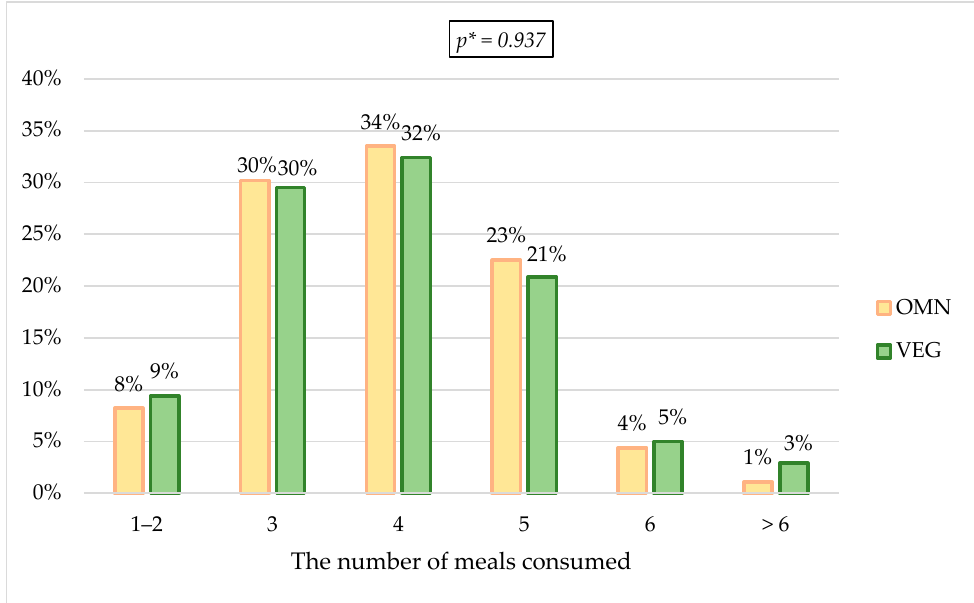
Figure 3. Changes in the number of meals before the pandemic. * p —calculated between the studied groups using Mann-Whitney U Test.